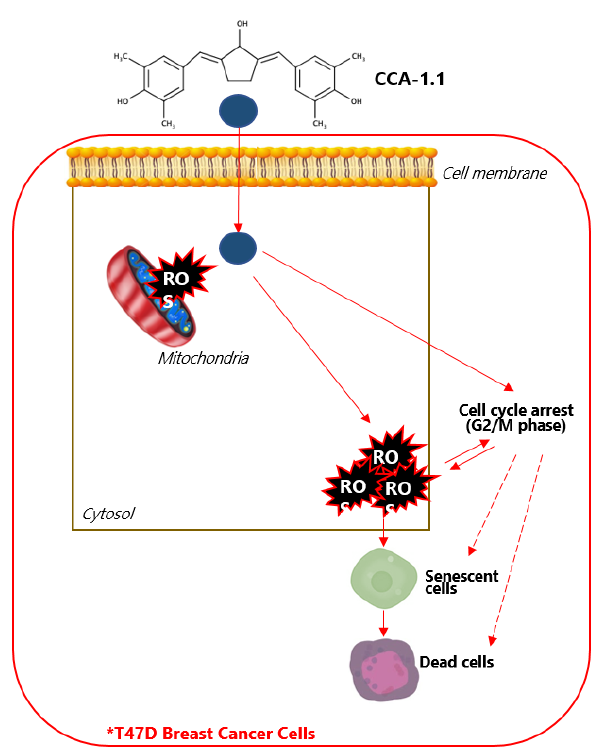
Figure 7. The proposed cytotoxic mechanism of CCA-1.1 in T47D breast cancer